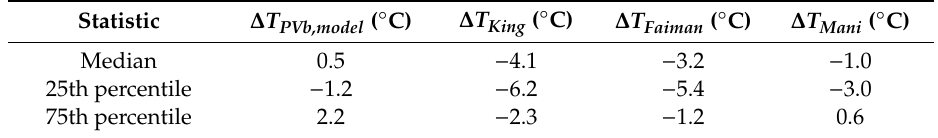
Figure 10. As in Figure 9, during a period of 5 consecutive partly cloudy days in May and time interval of 1 h. Note: time between the days is not continuous, the profiles are presented from sunrise to sunset.